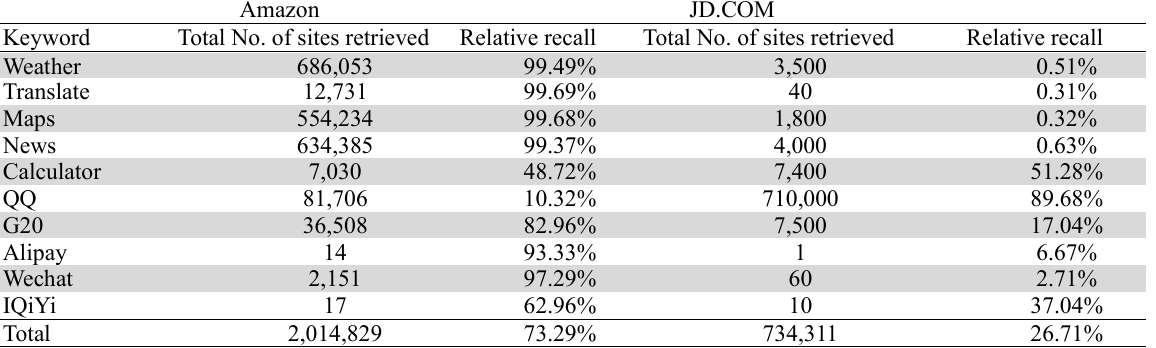
Relative Recall of Amazon and JD.COM SEs Amazon JD.COM